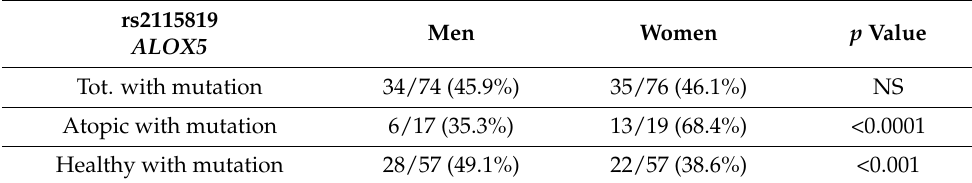
Table 3. Frequency of mutation in atopic and healthy M and W according to genotype ALOX5 rs2115819 polymorphism. The statistical tests used in these analyses were the one-way analysis of variance followed by the Tukey Multiple Comparison Test.